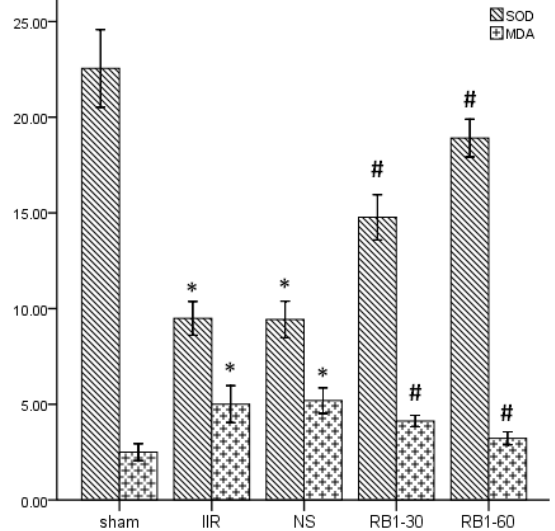
Figure 1. Changes of levels of SOD and MDA in renal tissues. * p < 0.05 vs. sham group, # p < 0.05 vs. IIR